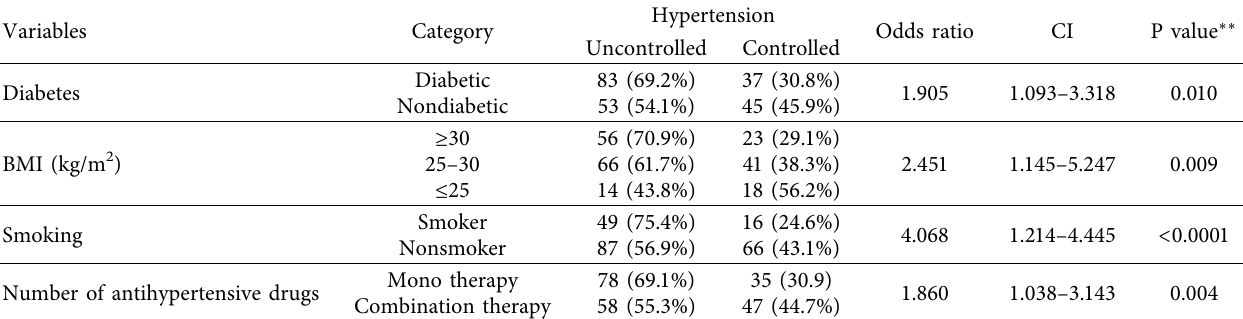
Table 5: Relationship between HTN control and selected risk factors after adjustment for confounding factors.